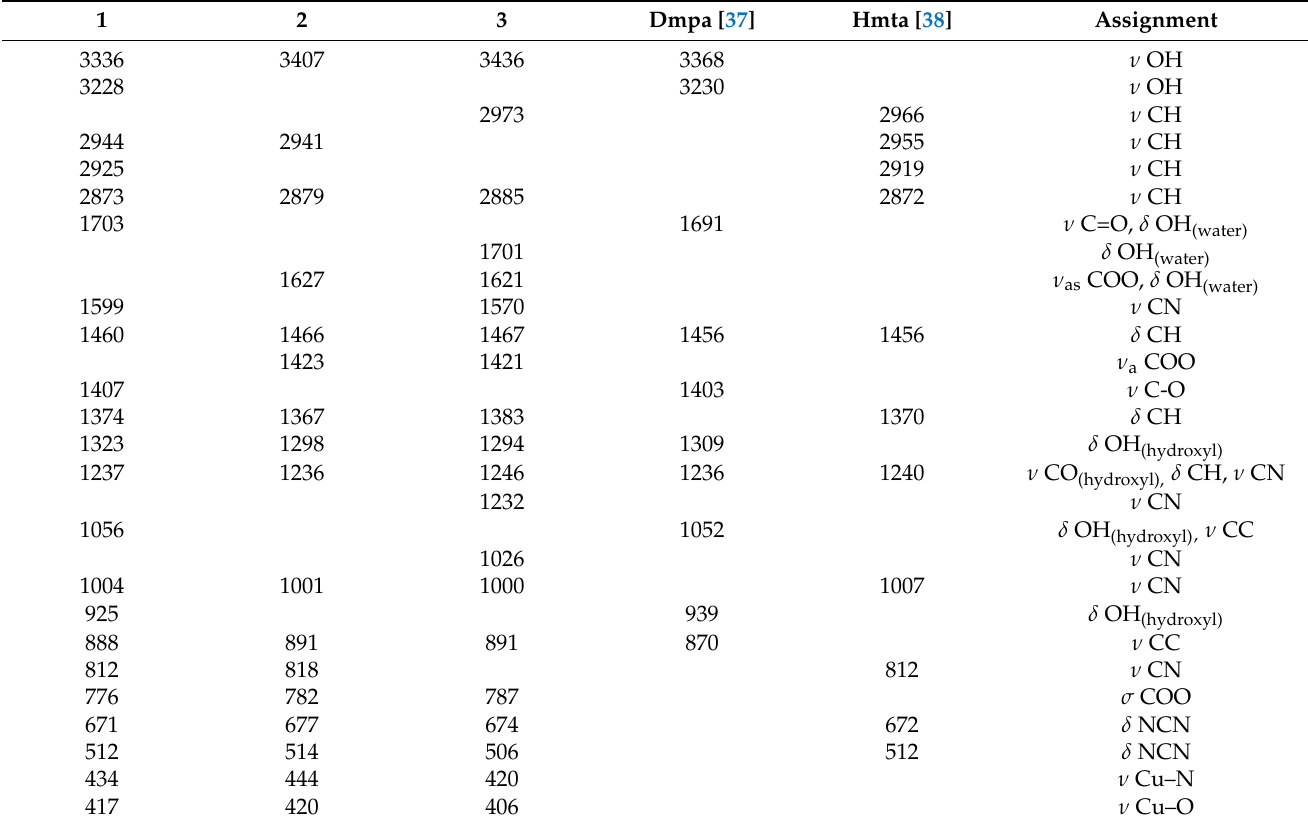
Table 3. Vibrational frequencies (cm − 1 ) and their assignments for the studied